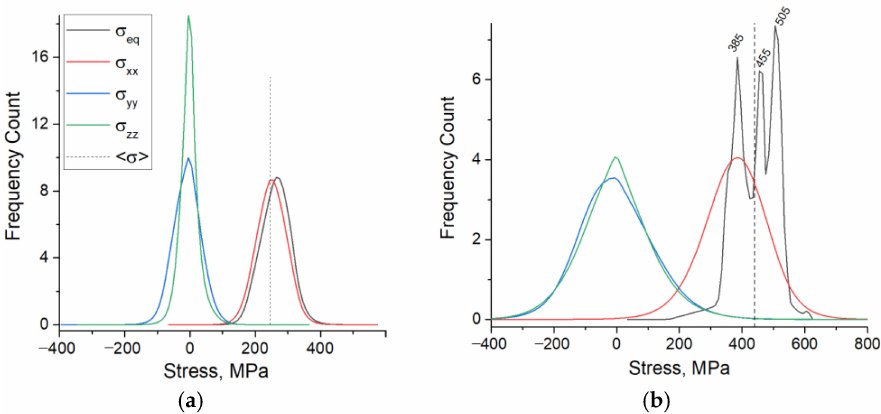
Figure 10. Frequency count distributions of the stress tensor components calculated for 0.22% ( a ) and 5% tensile strain ( b